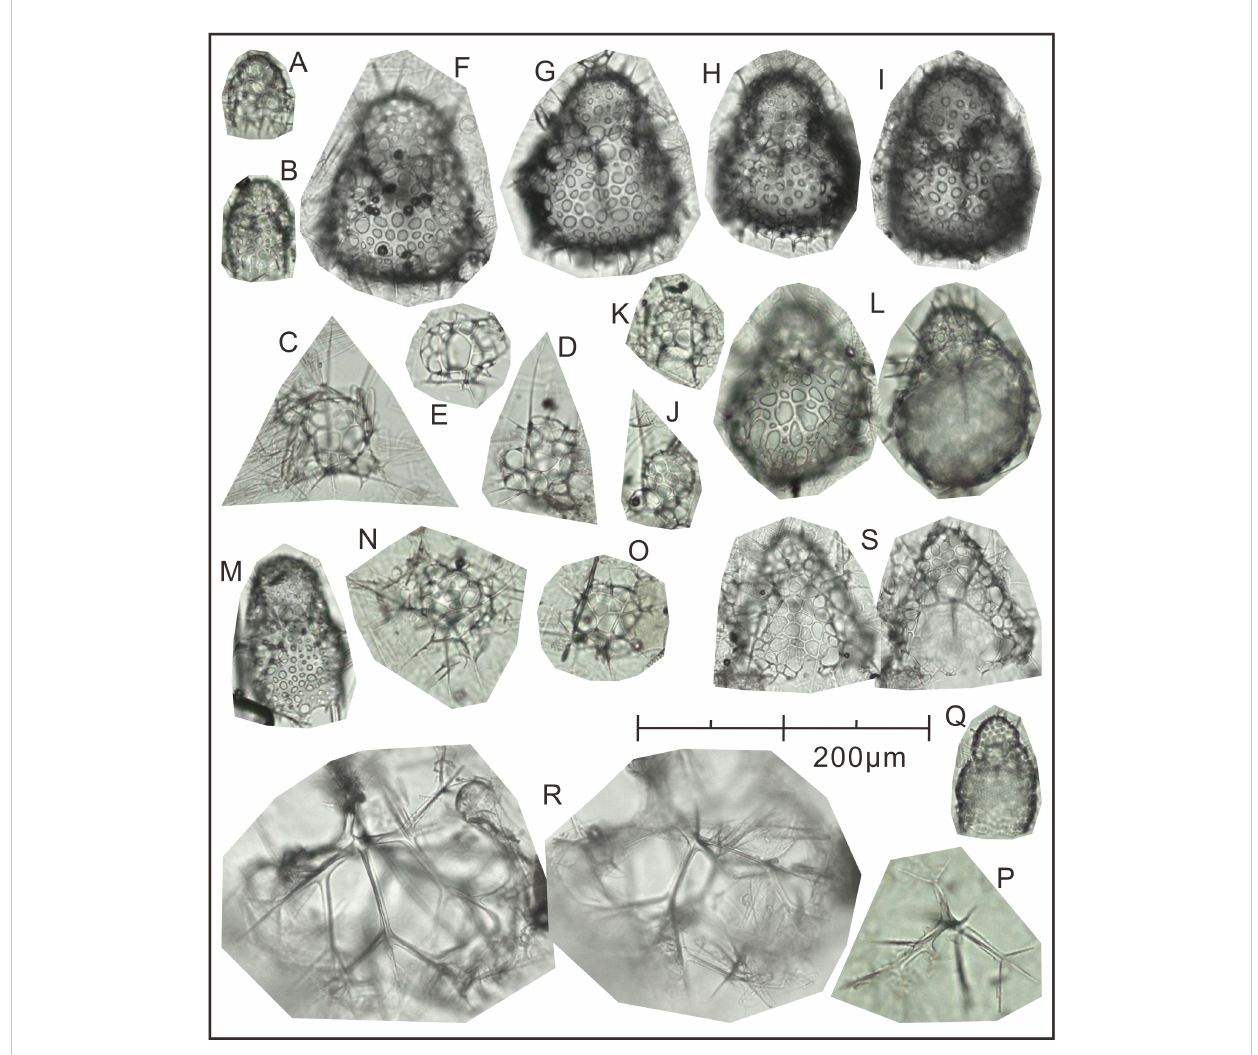
FIGURE 5 The plate of 15 dominant species identi fi ed at Station M8 in Prydz Bay polynya. (A) Antarctissa sp., Summer; (B) Antarctissa sp., Autumn; (C) Phormacantha hystrix , Summer; (D) Phormacantha hystrix , Spring; (E) Plectacantha oikiskos , Summer; (F, G) Antarctissa strelkovi , Summer; (H) Antarctissa denticulata , Summer; (I) Antarctissa denticulata , Autumn; (J) Peridium longispinum , Autumn; (K) Peridium sp., Autumn; (L) Antarctissa longa , Autumn; (M) Botryopera sp., Summer; (N) Phormacantha group, Autumn; (O) Plectacantha group, Autumn; (P) Pseudocubus sp., Autumn; (Q) Lithomelissa setosa , Spring; (R) Euscenium corynephorum , Autumn; (S) Ceratocyrtis histricosus ,